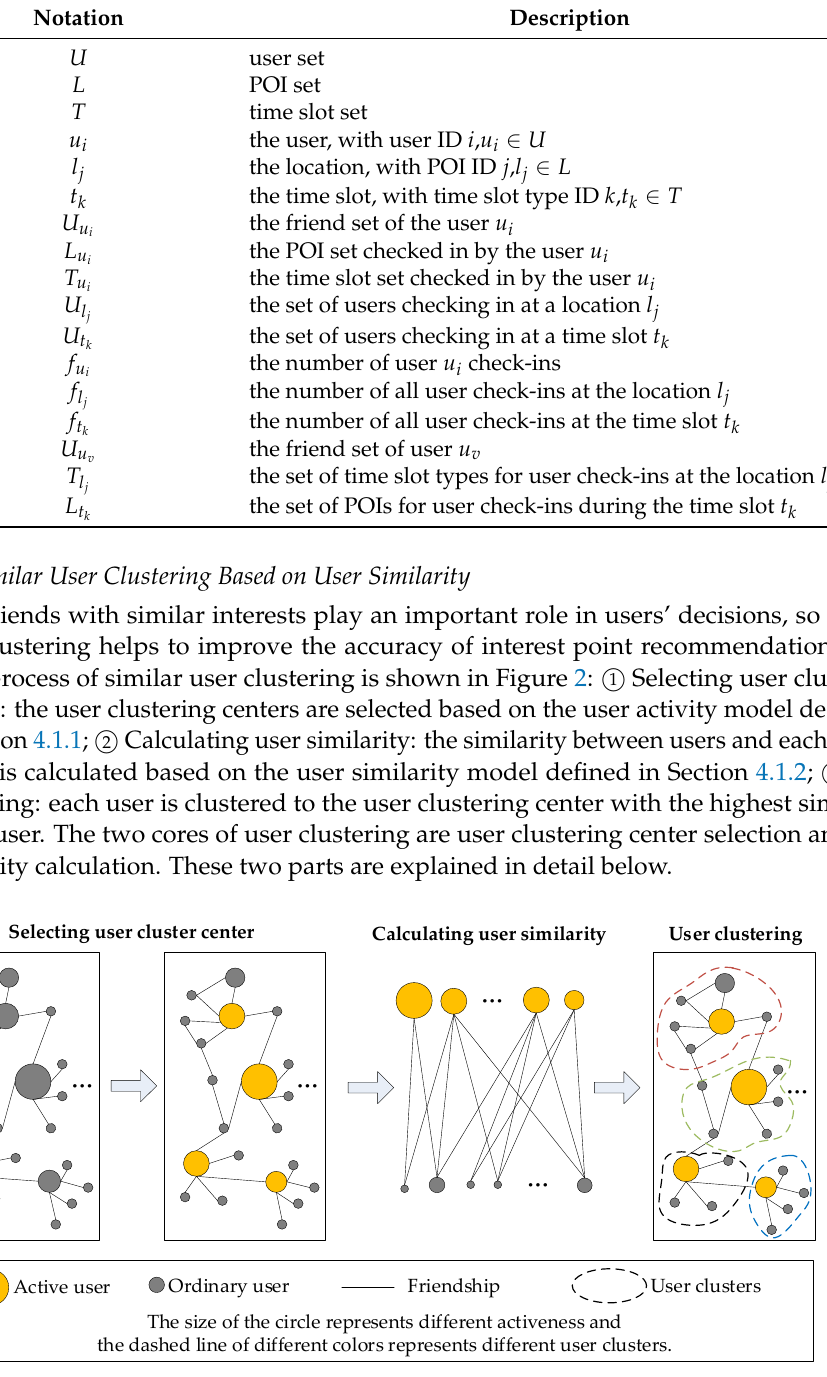
Figure 2. Similar user